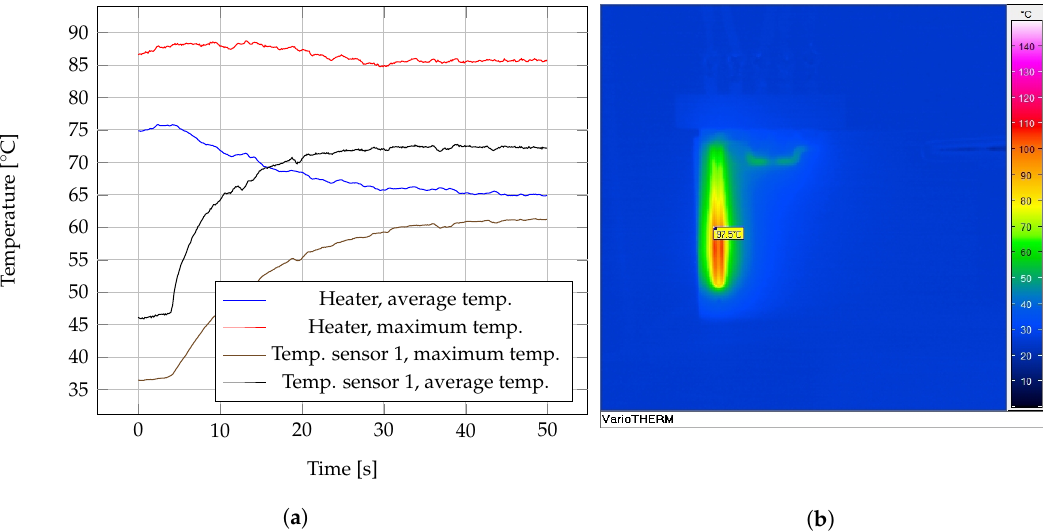
Figure 9. ( a ) Temperature time profile from infrarred imaging on working microfluidic device, 0.1mL/min. ( b ) Thermal infrarred imaging displaying heater temperature emission at